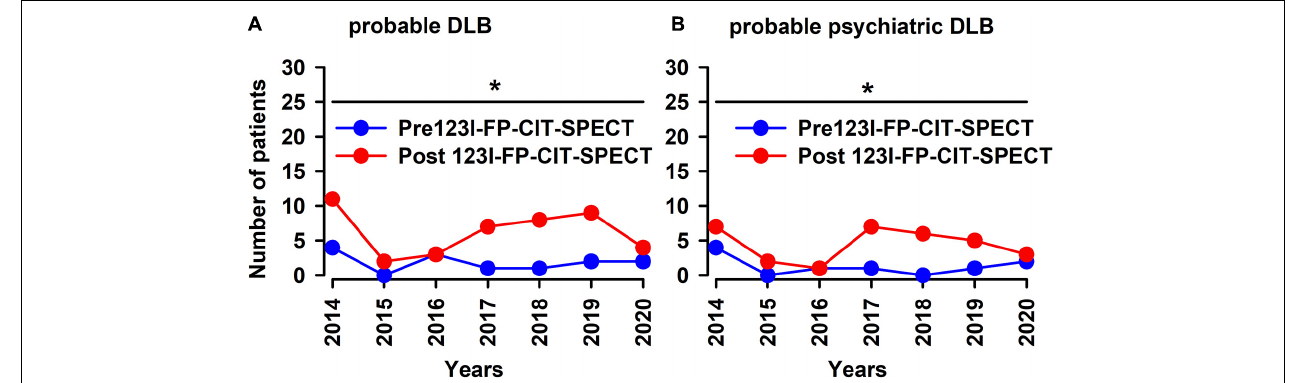
FIGURE 1 | 123I-FP-CIT-SPECT led to increased numbers of probable DLB patients during 2014–2020. 123-FP-CIT-SPECT led to increased probable DLB patients over a time period of 6 years in our psychiatry cohort (A) and in psychiatric-phenotype patients (B) . * p < 0.05, student’s t -test. DLB was diagnosed twice—before and after the 123-FP-CIT-SPECT.